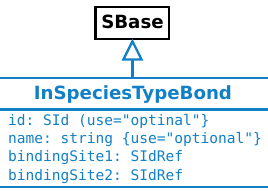
Figure 7: The definition of the InSpeciesTypeBond